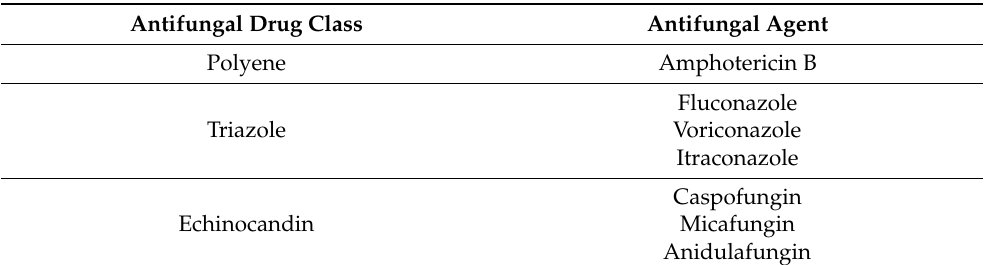
Table 2. Current antifungal agents licensed for the treatment of IC are limited to just three drug classes: the polyenes, triazoles and echinocandins